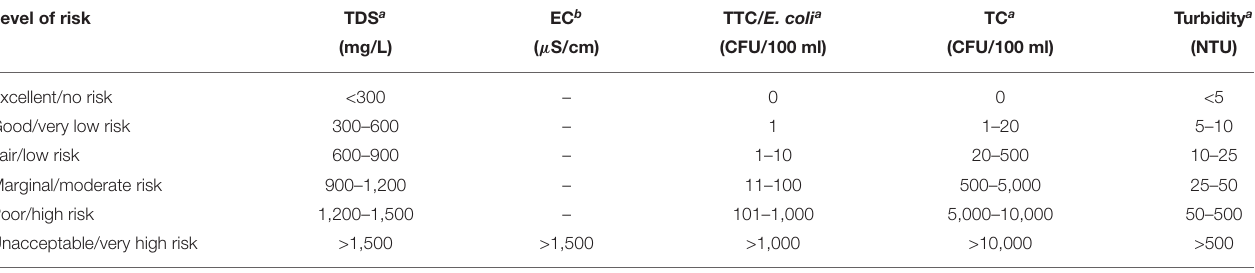
TABLE 4 | Water quality ratings based on total dissolved solids (TDS), electrical conductivity (EC), thermotolerant coliforms (TTC), total coliforms (TC), and turbidity.